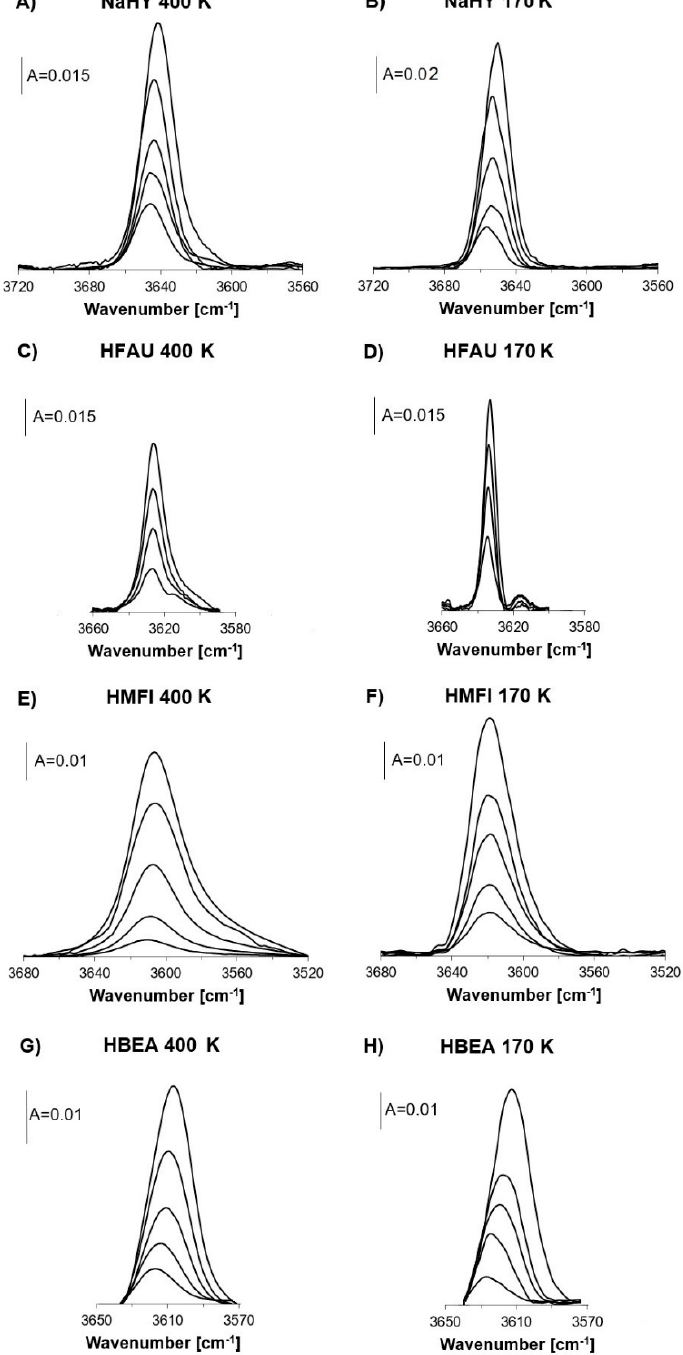
appears at ca. 3500 cm − 1 , i.e., in the region in which NH 4+ bands are absent. The frequency shift of OH…N 2 band (similarly as OH…CO) increases with the acid strength of OH [60,61].